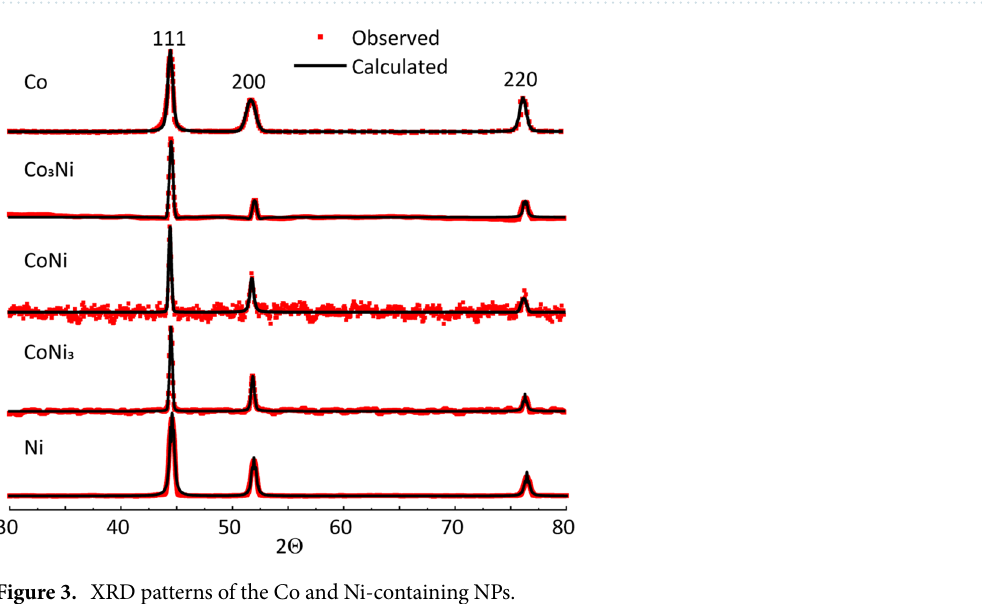
Figure 2. SEM images and results of EDS analysis (at.%) of the ( a ) Co, ( b ) Co 3 Ni, ( c ) CoNi, ( d ) CoNi 3 , and ( e ) Ni NPs. The scale bar equals 10 µm.